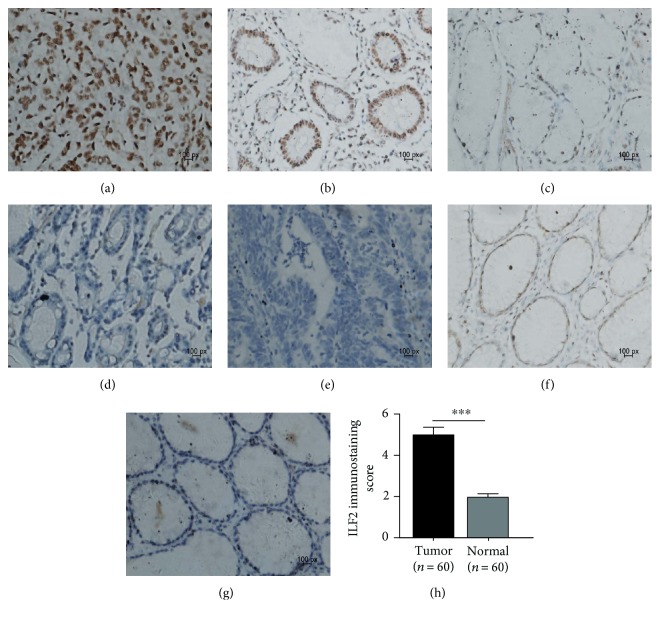
Representative microphotographs for ILF2 protein expression by IHC staining in GC tissues and corresponding normal gastric tissues. ILF2 protein in GC tissues in strong staining (sepia) (a), moderate staining (claybank) (b), weak staining (light yellow) (c), no staining (d), and negative controls (e). Weak staining (light yellow) (f) and barely stained (g) adjacent normal gastric tissues. The comparison of ILF2 immunostaining score between GC tissues (n = 60) and normal gastric tissues (n = 60); the results are presented as mean ± SEM (∗∗∗p < 0.001) Wilcoxon matched-pairs signed-ranks test (h) (original magnification: ×400 in (a)–(g)).